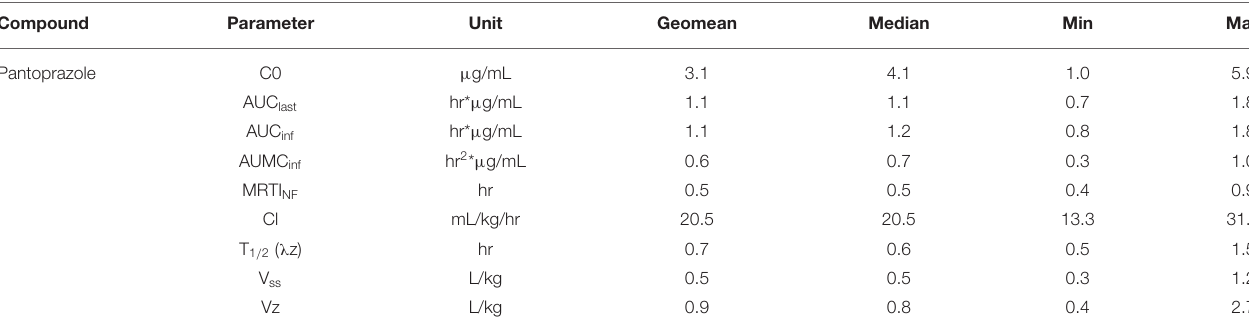
TABLE 1 | Pantoprazole pharmacokinetic parameters following a single intravenous (1 mg/kg) administration to adult goats. Compound Parameter Unit